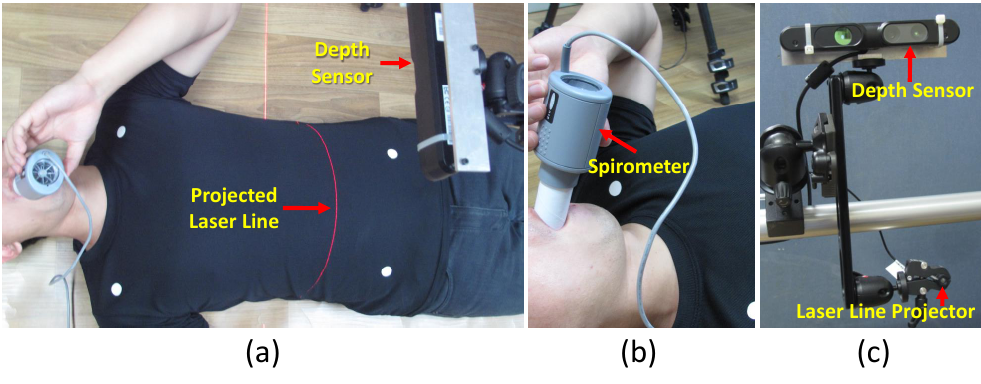
Figure 10. Experimental setup for evaluating the accuracy of the proposed method using a spirometer and a laser line scanner. ( a ) Volunteers are advised to lay down in the supine position and breath only through the spirometer. The RGB-D camera and laser line projector are placed above the volunteer, and the laser line is projected onto the abdomen area. ( b ) CareFusion SpiroUSB TM spirometer. ( c ) The configuration of the RGB-D camera and laser line